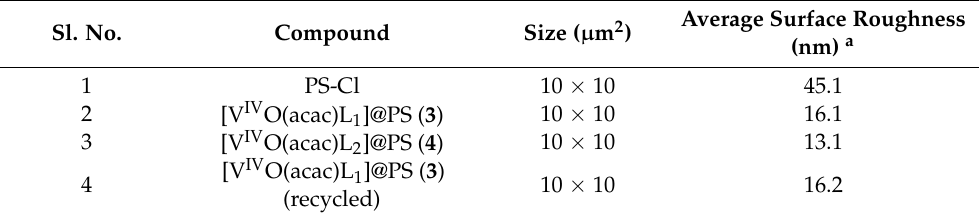
Table 3. AFM image parameters of the polymer beads in neat and supported complexes. Sl.